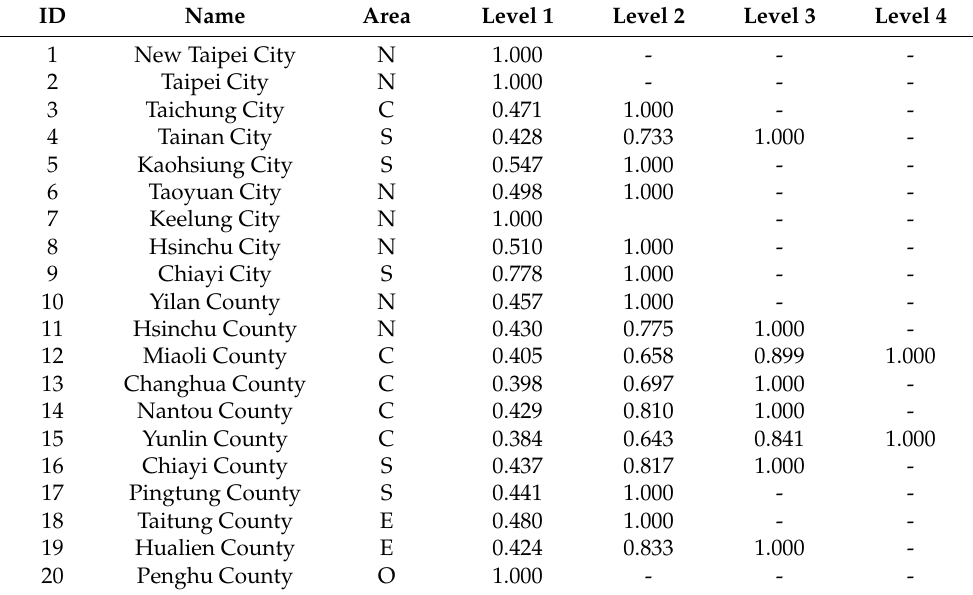
Table 3. Multi-level overall technical efficiency frontiers of counties and cities in